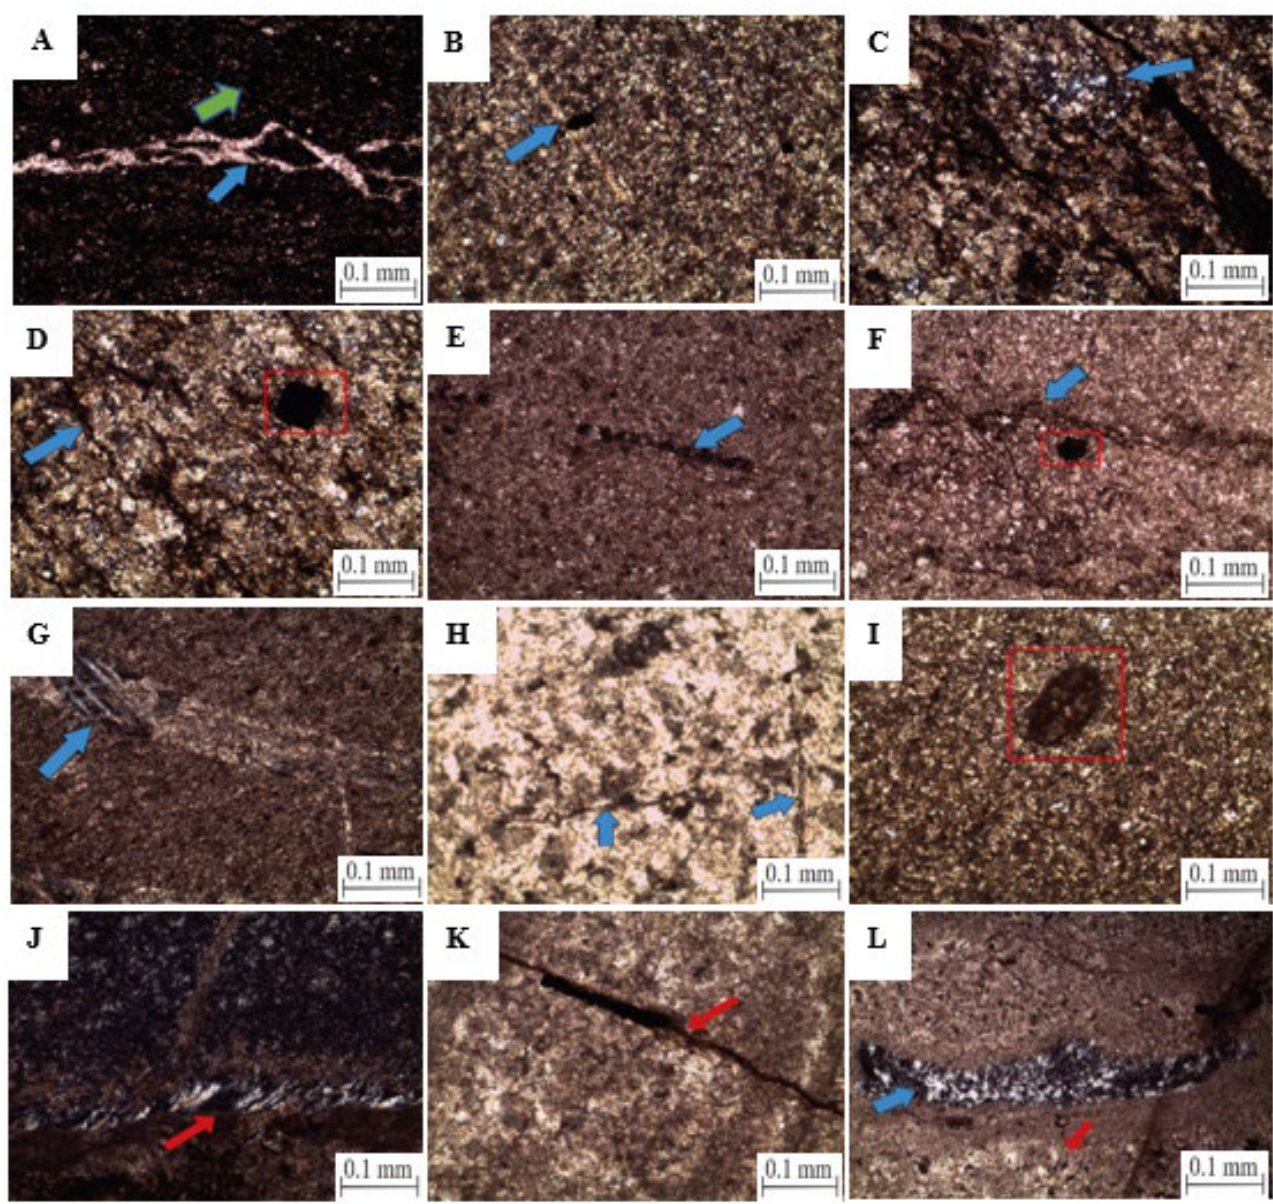
Figure 6. Photomicrographs of the Dol. I microfacies of the Abbottabad Formation. ( A ) Partially dolomitized vein (blue arrow) and carbonaceous material in fine dolomite rhombs (green arrow) (KA-1; PPL. 10×). ( B ) Fine equigranular, planar-s dolomite facie and pyrite grains upon dolomite vein (blue arrow) (KA-2; XPL. 10×). ( C ) Fine crystalline dolomite with chalcedony (blue arrow) (KA-3; XPL. 10×). ( D ) Stylolite veins highlighted by hematite (blue arrow) and rectangle showing cubic pyrite in planar dolomite facie (KA-3; XPL. 10×). ( E ) Bioclast in fine crystalline dolomite (blue arrow) (KA-4; PPL. 10×). ( F ) Stylolite vein (blue arrow) and rectangle showing hematite grain (KA-4; PPL. 10×). ( G ) Calcite and dolomite vein (blue arrow) in fine crystalline dolomite (KA-19; XPL. 10×). ( H ) Bioclasts in fine crystalline dolomite (blue arrows) (KA-27; XPL. 10×). ( I ) Bioclast in fine crystalline dolomite (KA-31; PPL. 10×). ( J ) Chalcedony vein (red arrow) and chert in dolomite (KA-37; XPL. 10×). ( K ) Hematite vein in dolomite (KA-37; XPL. 10×). ( L ) Chalcedony patches (blue arrow), and chert (red arrow) in fine planar-s dolomite (KA-44; XPL. 4×).